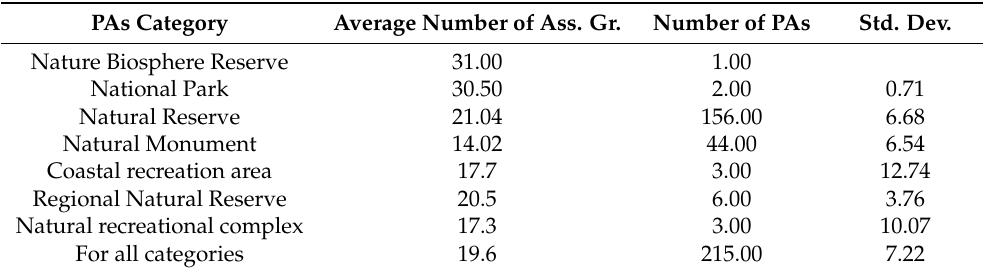
Table 3. Breakdown table of groups statistics of the typological diversity of forests by PAs categories (ANOVA: F = 6.78, p =